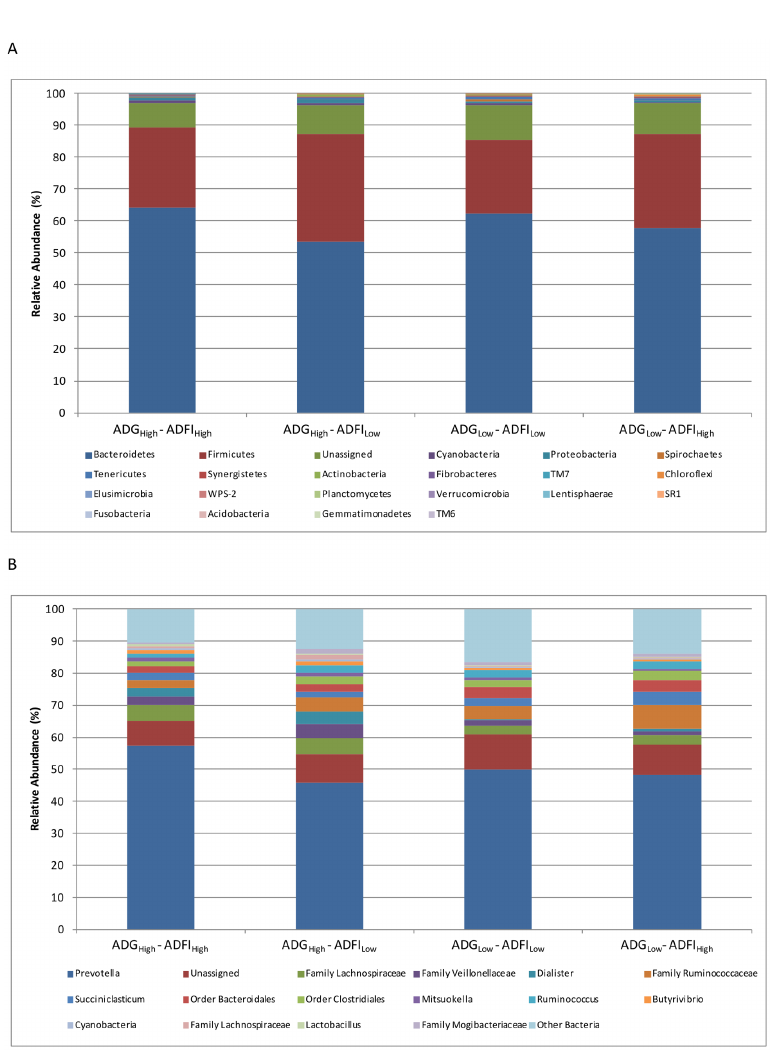
Fig 3. The taxonomic profiles for the relative phylum-level (A) and genus-level (B) abundance of each group classified by representation at > 1% of total sequences. Taxonomic composition of the ruminal microbiota among the four groups was compared based on the relative abundance (reads of a taxon/total reads in a